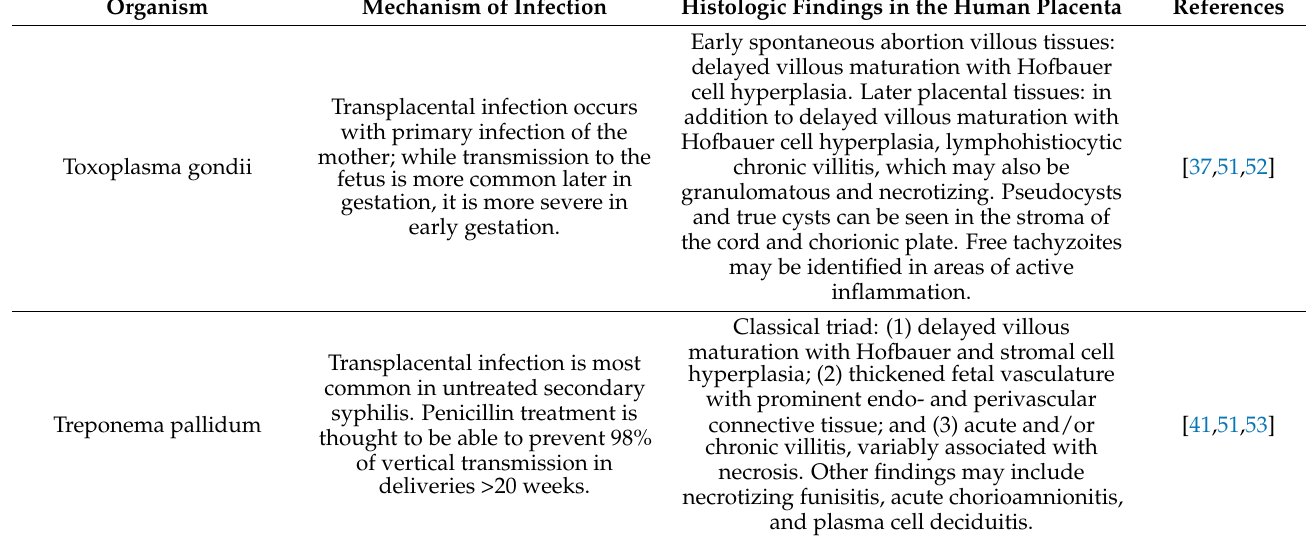
Table 1. Infectious agents with known teratogenic